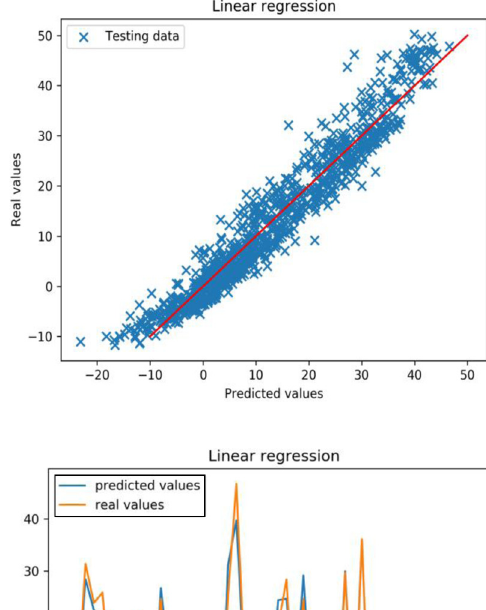
Figure 6. Line chart of real value and predicted value with MLR